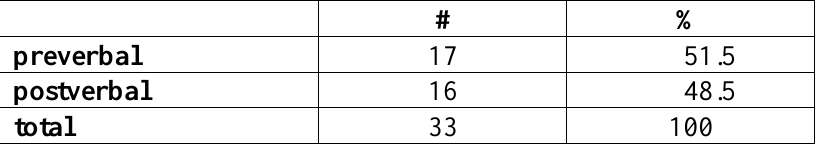
Table (10): Positioning of tú in direct non-cleft argumental wh -interrogatives